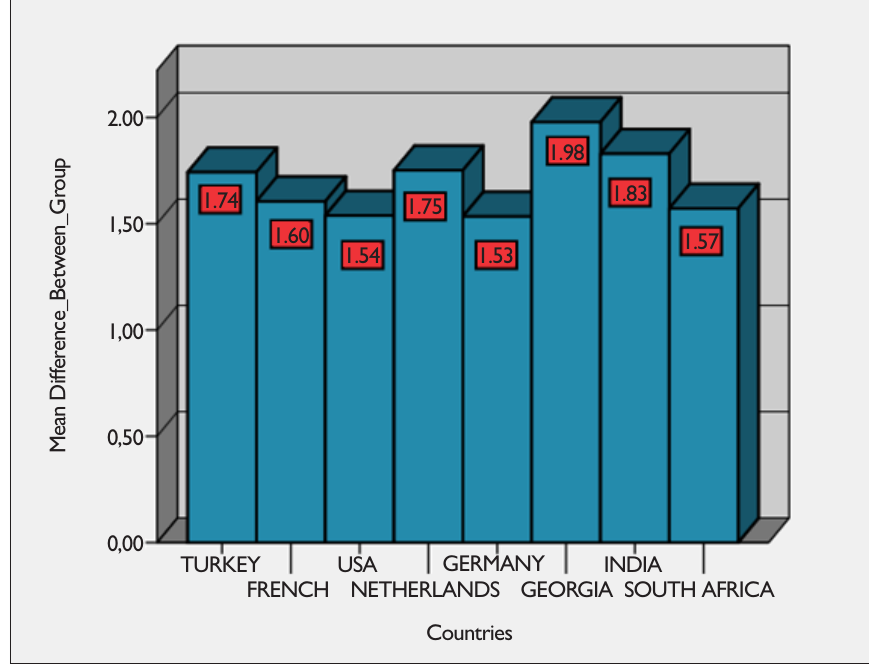
Figure 1. The Means (M) of the